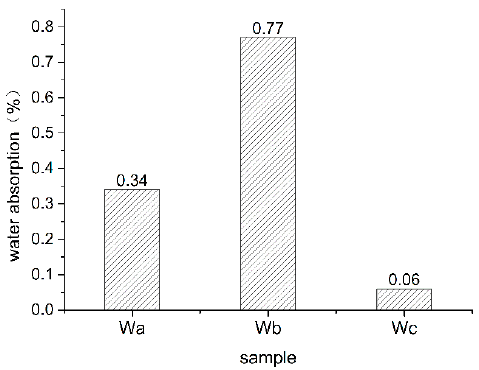
Figure 2. Average water absorption of oil shale at different heating temperatures (Wa, Wb, Wc, respectively, represent oil shale heated to 300 °C, oil shale heated to 500 °C, and unheated oil shale).